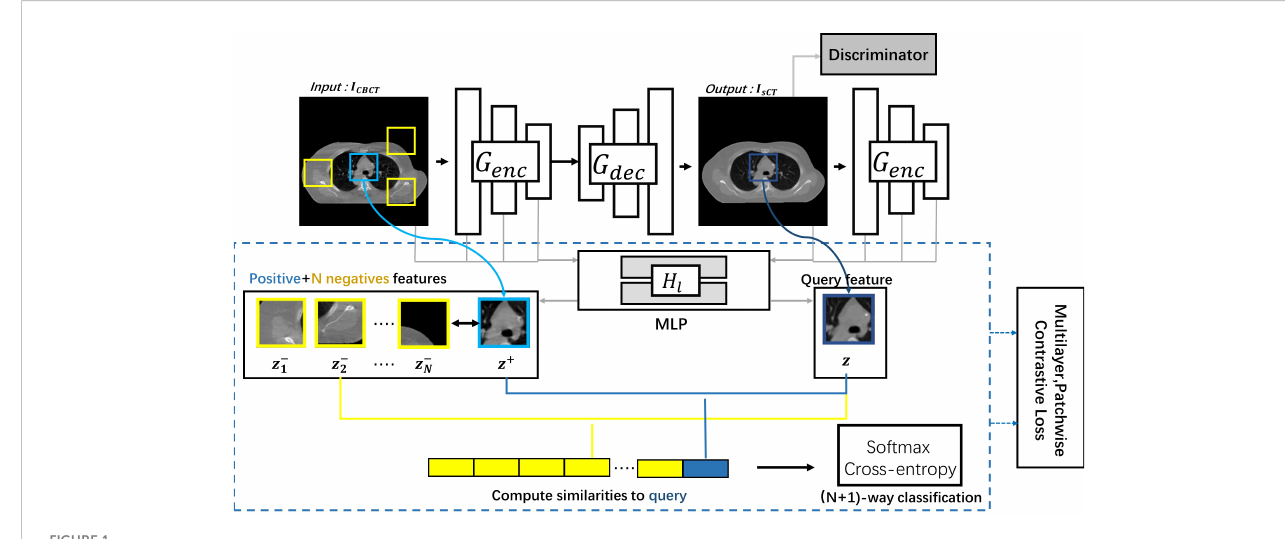
FIGURE 1 The CLG model network